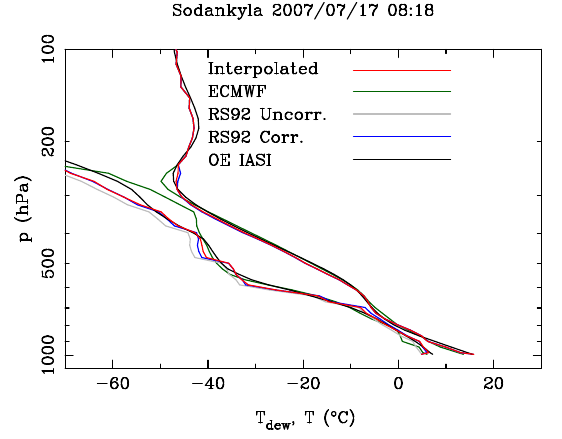
Figure 1. Temperature and dew point temperature of the different profiles used in this paper. The OE IASI retrieval is also shown (in black) for reference purposes